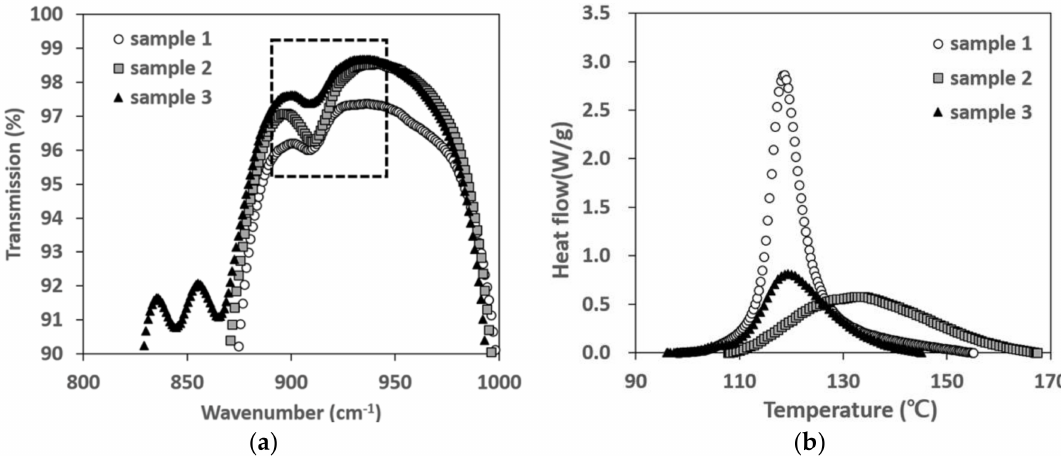
Figure 5. ( a ) Comparison of absorption peaks of the three resins: to be drawn by narrowing to 800–1000 cm − 1 and ( b ) DSC heat flow result among the 3